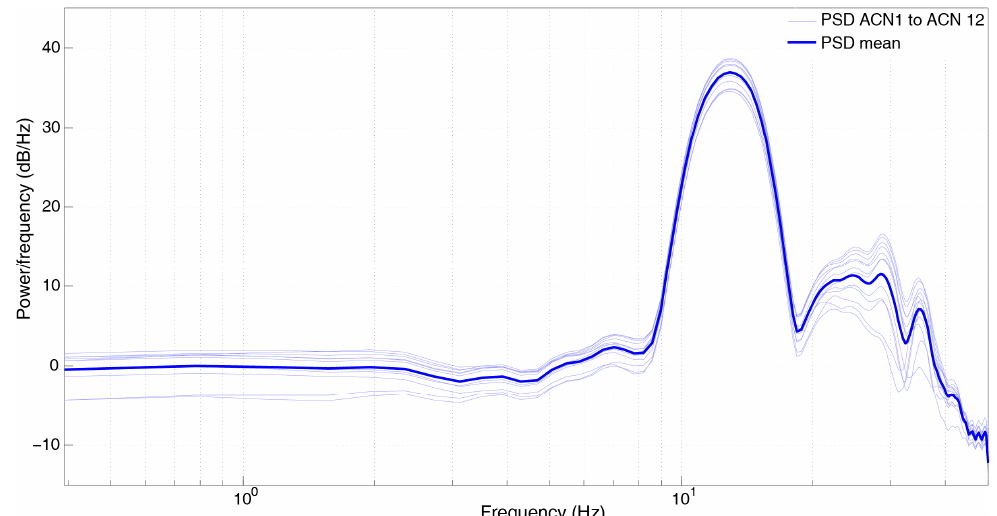
Figure 14. ACN modules connected to Mark L4 1 Hz s ensors.